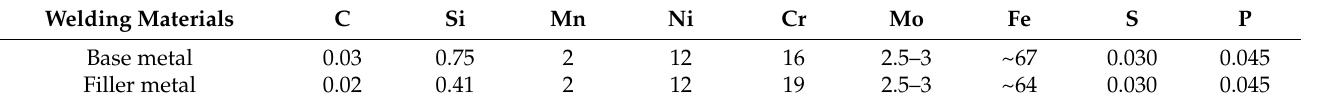
Table 2. Chemical composition of the base and filler material.